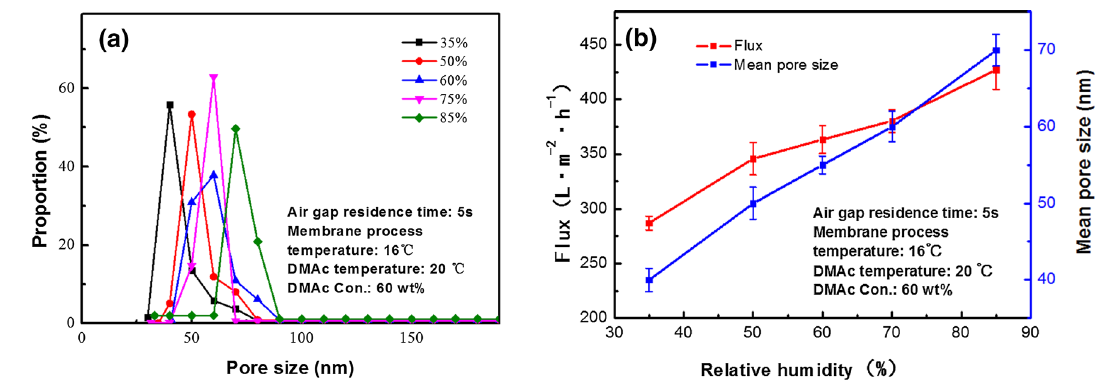
Fig. 5 a The pore size distributions and b the PWF distributions of membranes prepared under different relative